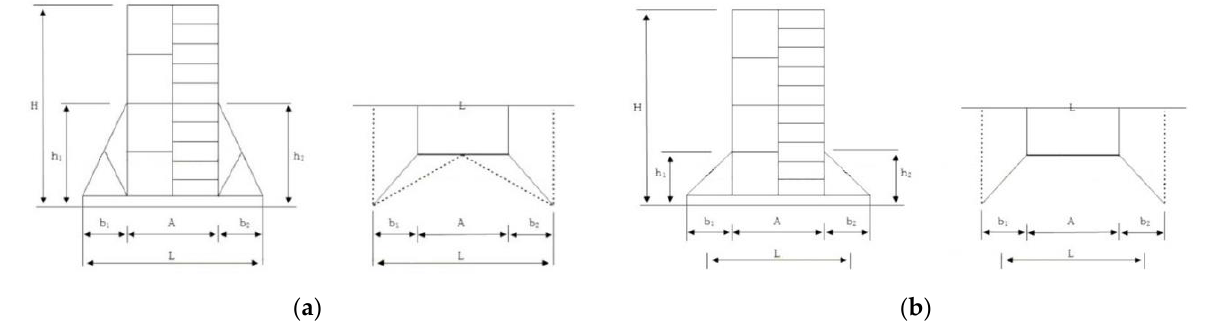
Figure 6. Height limitation of fabricated mobile scaffold. ( a ) Method A. ( b ) Method